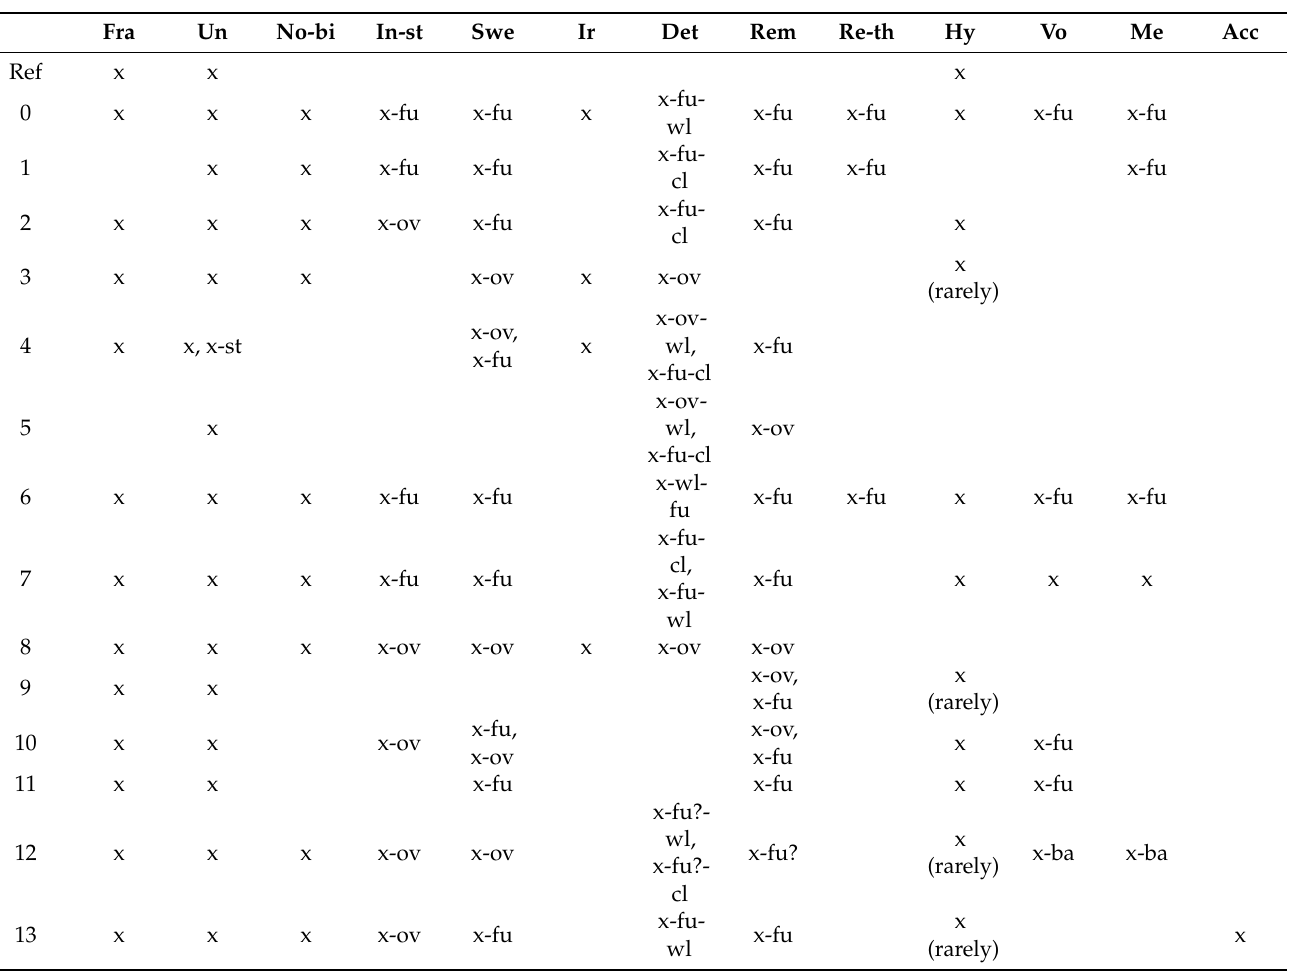
Table 2. Occurrence of degradation features in samples. x indicates the feature was present in the analysed sample. Fractures, unfolding of thin-walled cells and hyphae are also present in the reference material, a piece of contemporary intact birch